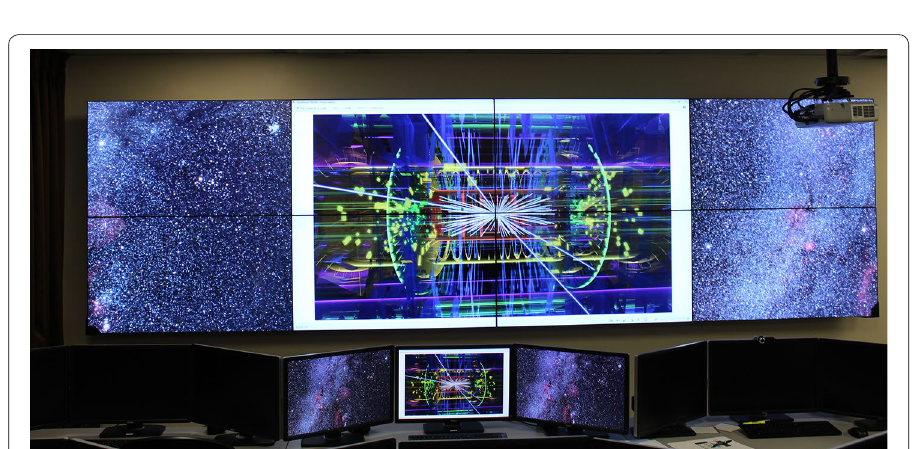
Fig. 12 Image showing the selected LCR (centered) choice from the Hiperwall User after the user has selected to send all three